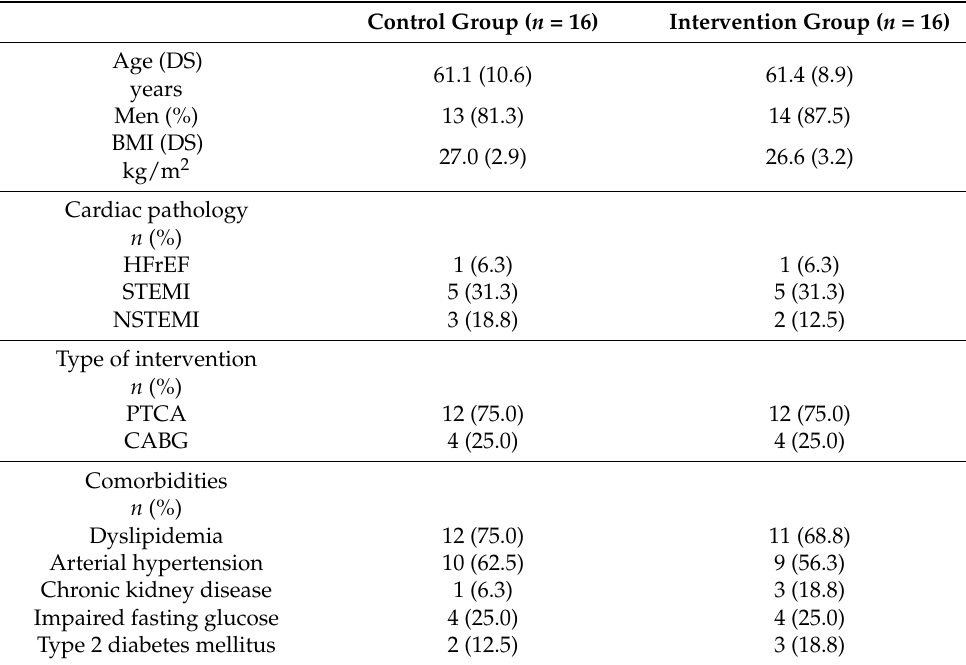
Table 1. Baseline characteristics of the study